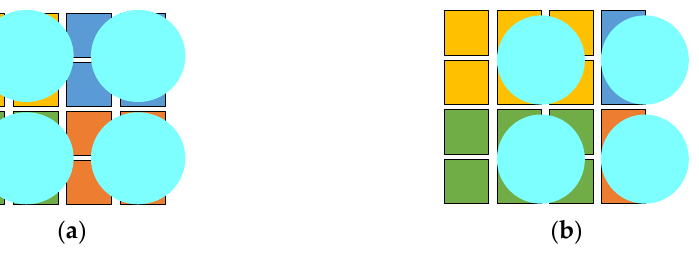
Figure 7. Spot distribution under different link misalignments. ( a ) Small degree of link misalignment. ( b ) Large degree of link misalignment.